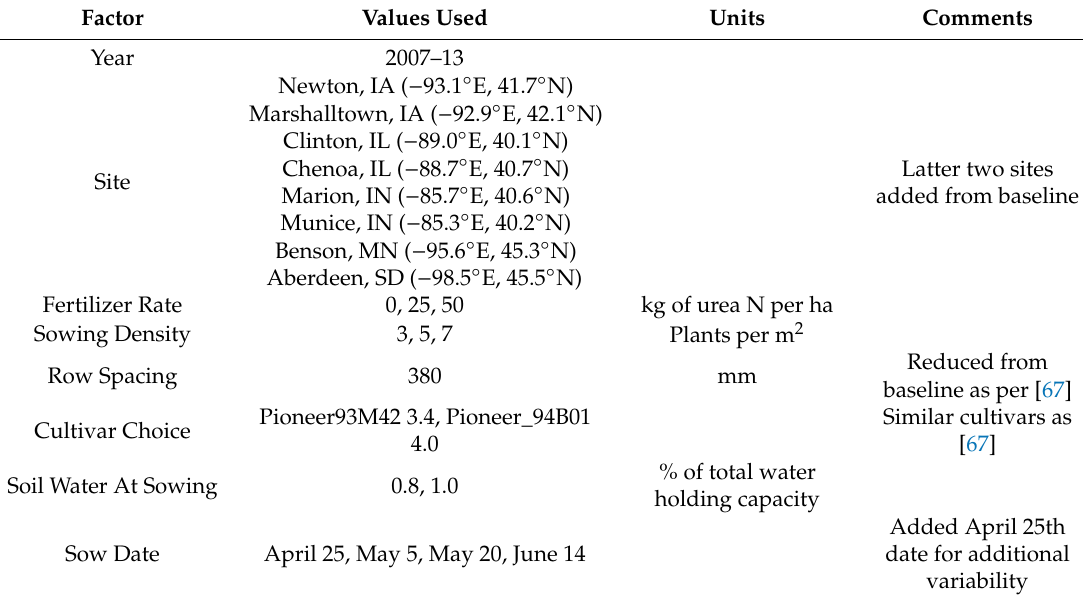
Table 4. Summary of Agricultural Production Systems sIMulator (APSIM) settings for crop simulations. Comments note changes from Lobell (2015) baseline parameters